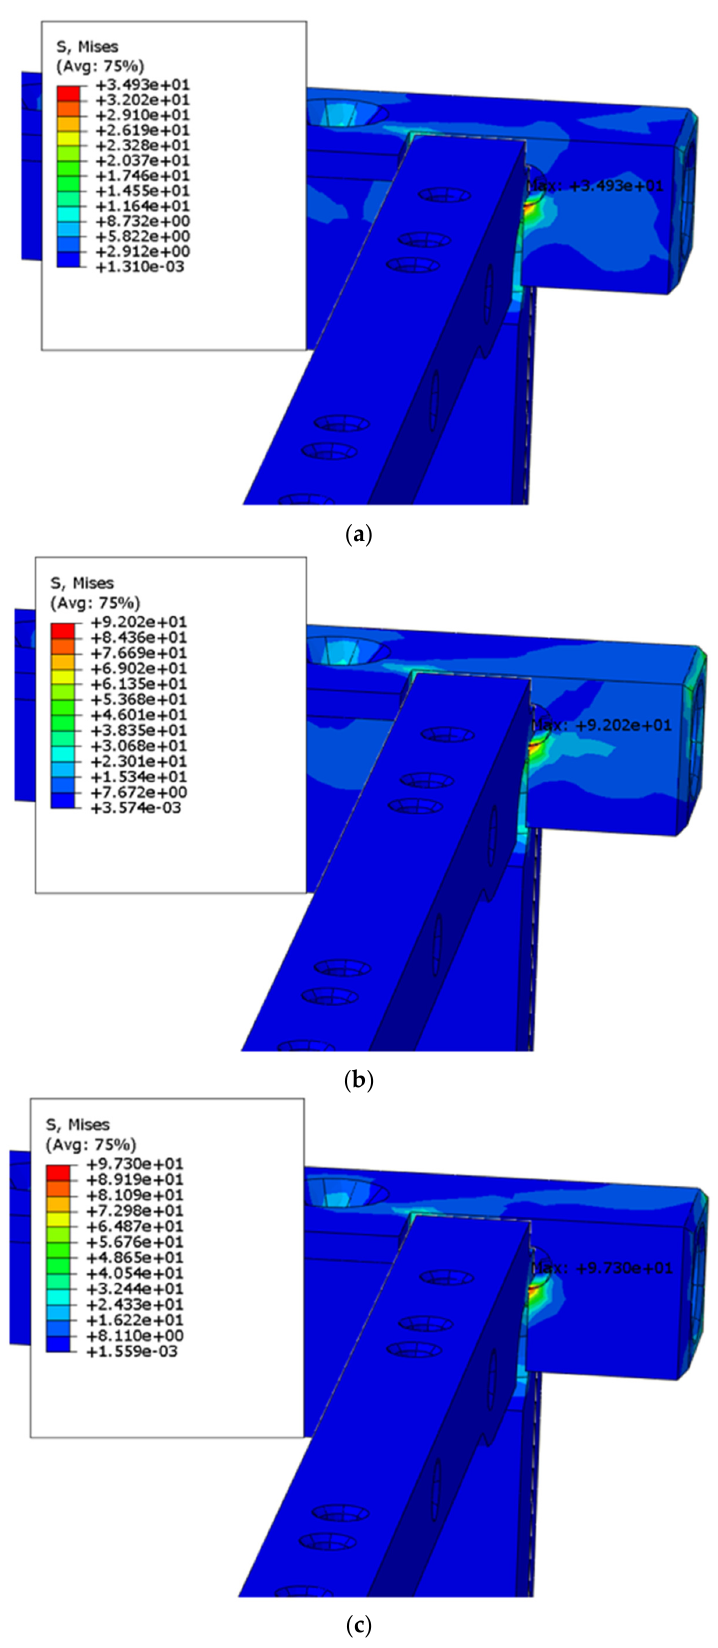
Figure 15. Maximum stress ( MPa ) in frame—zoomed: ( a ) Case A; ( b ) Case B; ( c ) Case C.